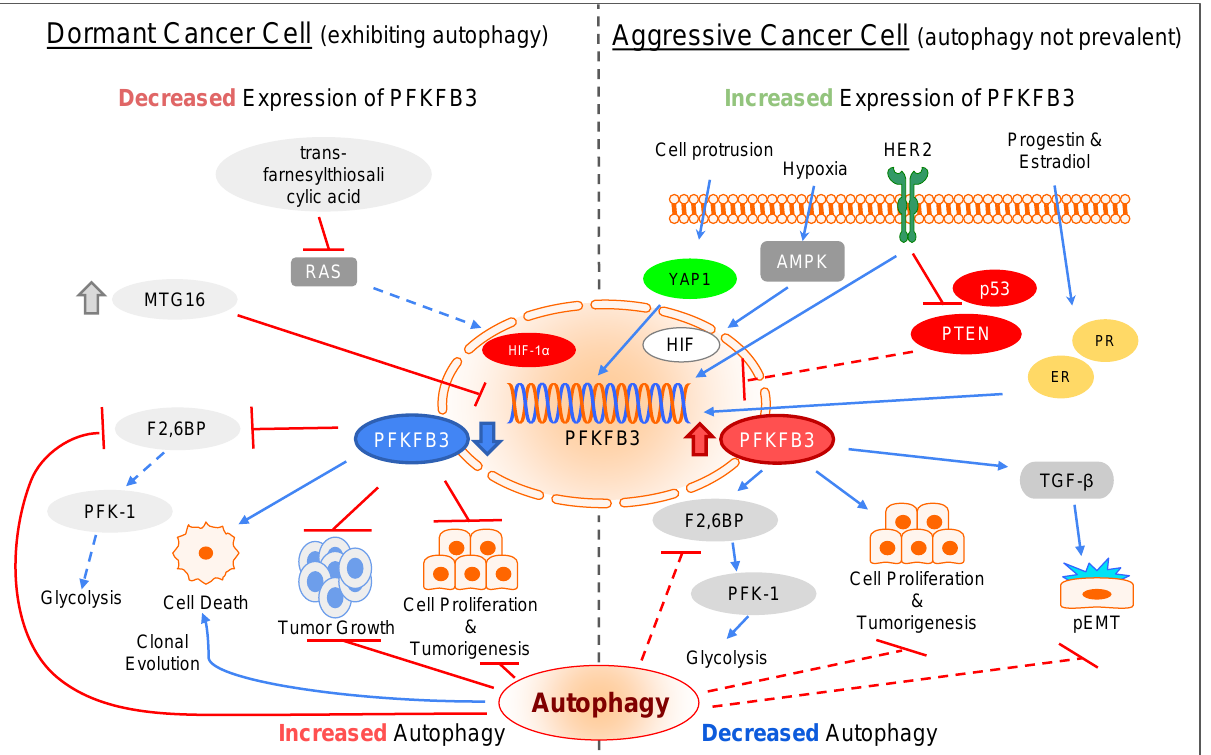
Figure 5. Key roles of PFKFB3 expression in ECM stiffness-induced autophagy through changes in glucose metabolism. ( Left panel) In dormant cancer cells, autophagy is activated through several ways: (i) trans-farnesylthiosalicylic acid inhibits the RAS pathway, leading to the downregulation of HIF- 1α and subsequent PFKFB3 expression; (ii) upregulation of MTG16, a transcriptional repressor functioning as a tumor suppressor, reducing PFKFB3 expression. PFKFB3 downregulation inhibits tumor growth, cell proliferation, and tumorigenesis, and promotes cell death. In addition, the activity of F2,6BP can be also inhibited, leading to downregulation of PFK-1 and glycolysis. ( Right panel) During cancer development or dormancy reactivation, autophagy is not prevalent through several means that can upregulate PFKFB3 expression: (i) mechanosensing through cell